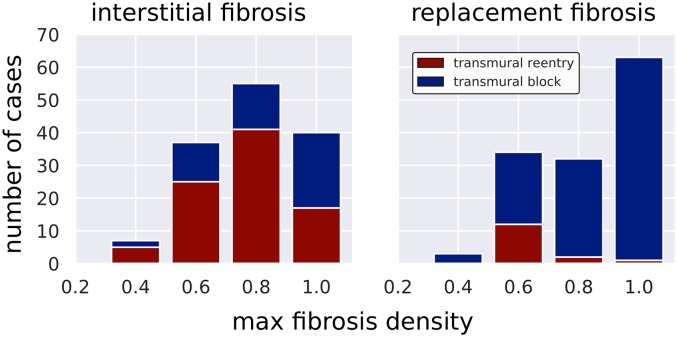
Number of simulated electrical instabilities (transmural block or transmural reentry) observed in 699 LGE-CMR derived simulation models for each combination of fibrosis type and density.